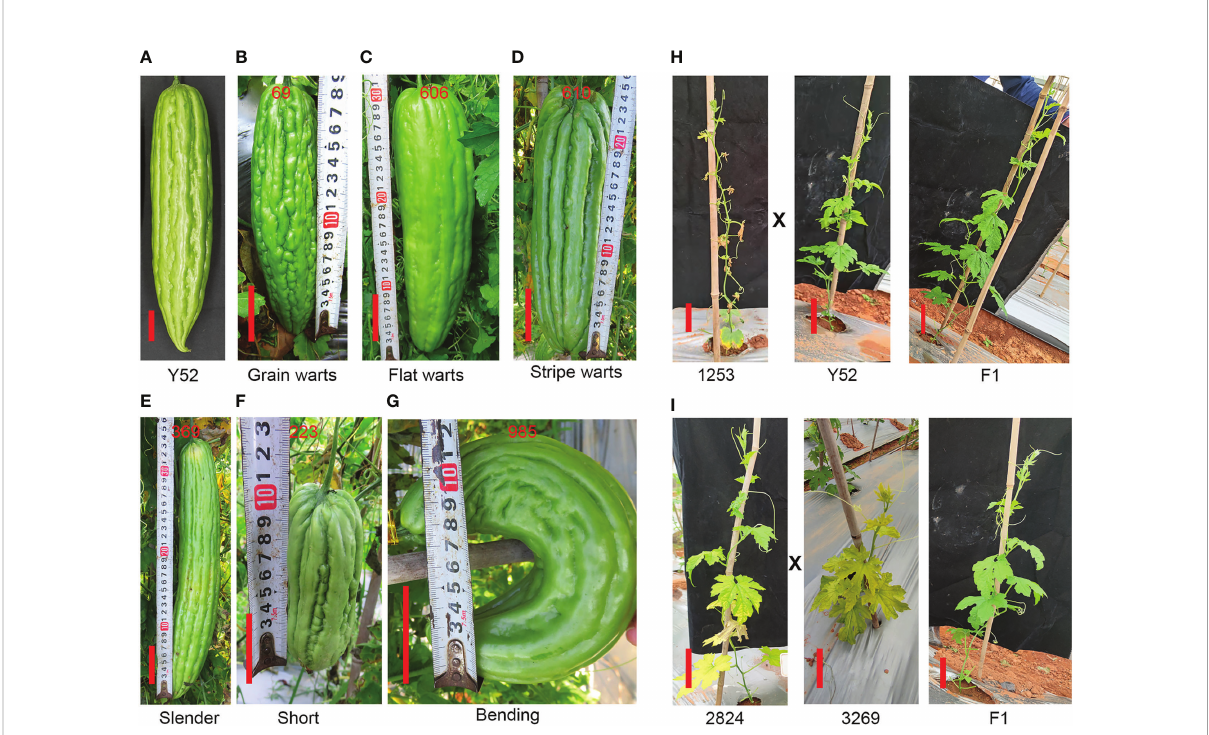
FIGURE 6 Different kinds of phenotype of fruit (A – G) and the phenotype of the F 1 generation (H, I) . (A) Fruit of Y52. (B – D) The phenotype of fruit with grain, fl at and stripe warts. (E – G) Slender, short and bending fruit. The phenotype of the F 1 generation generated by Y52 crossed with 1253 (H) , and 2824 crossed with 3269 (I) compared to Y52, respectively. Scale bar in red color = 5